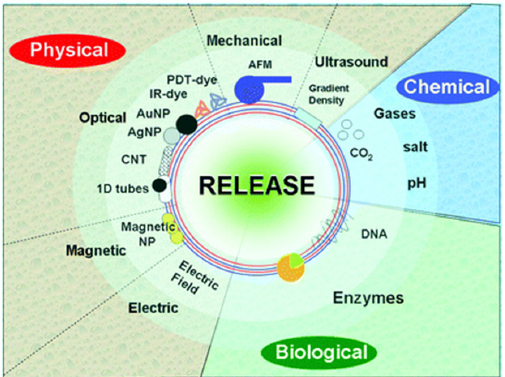
Figure 11. Scheme of different type of stimuli that can be exploited for encapsulation and release of encapsulated compounds from LbL materials. Reproduced from Skirtach at al. [37], Copyright (2011), with permission from The Royal Society of Chemistry.